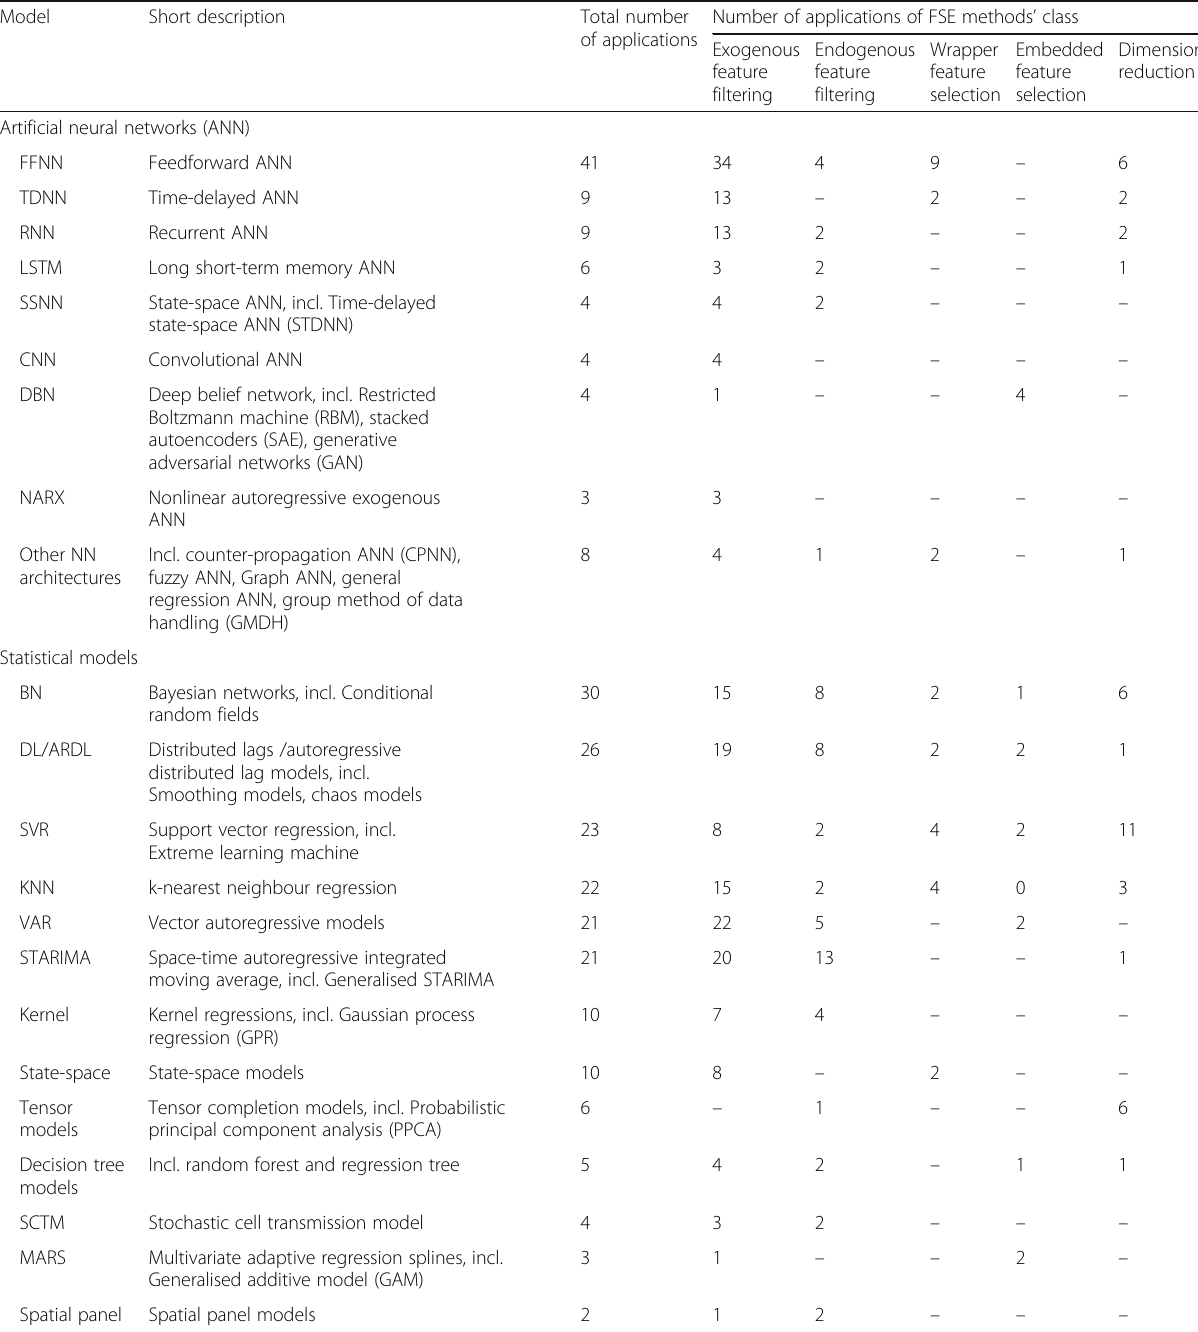
Table 2 Coverage of traffic forecasting methodologies by FSE methods